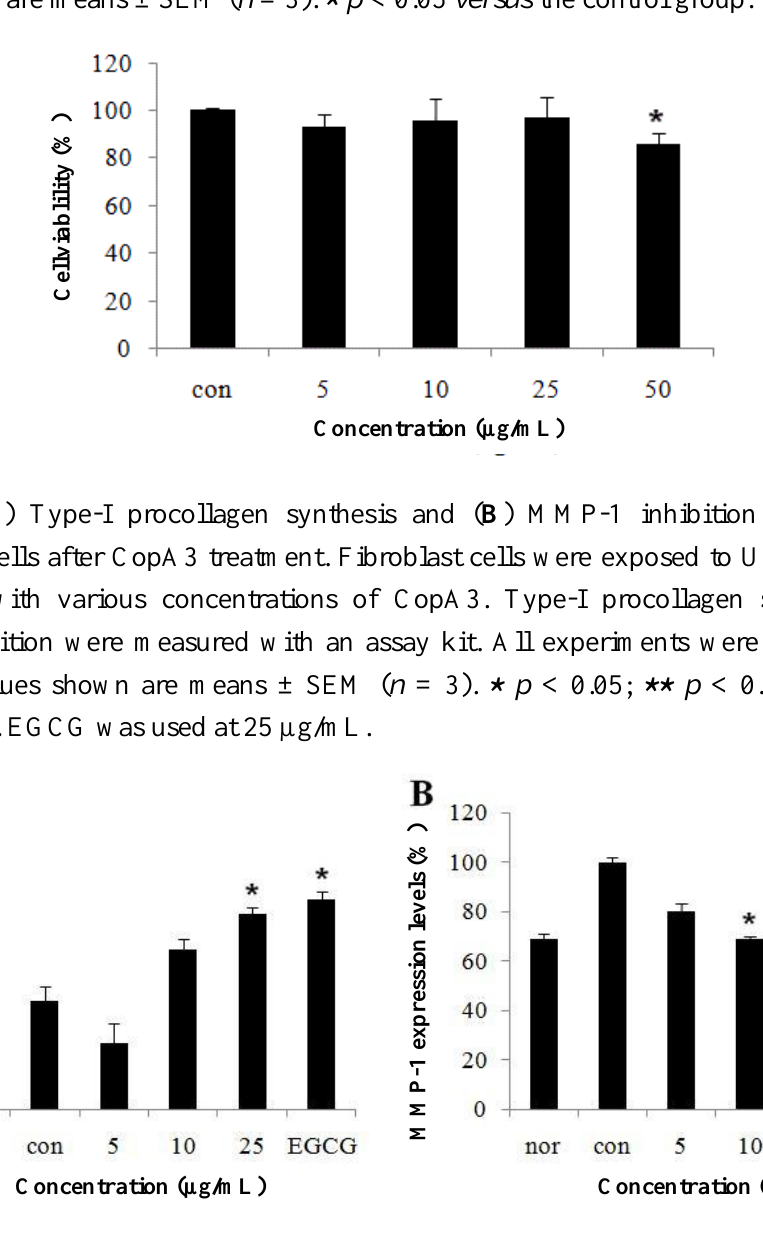
Figure 1. Cell viability of fibroblast CCD-986sk cells after CopA3 treatment. Fibroblast cells were exposed to UVB for 1 min and treated with various concentrations of CopA3.